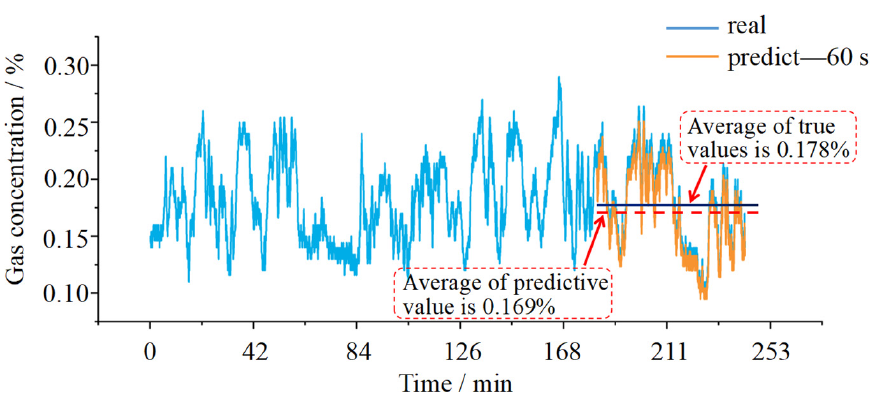
Figure 11. Gas concentration prediction of the model with an update period of 60 s.